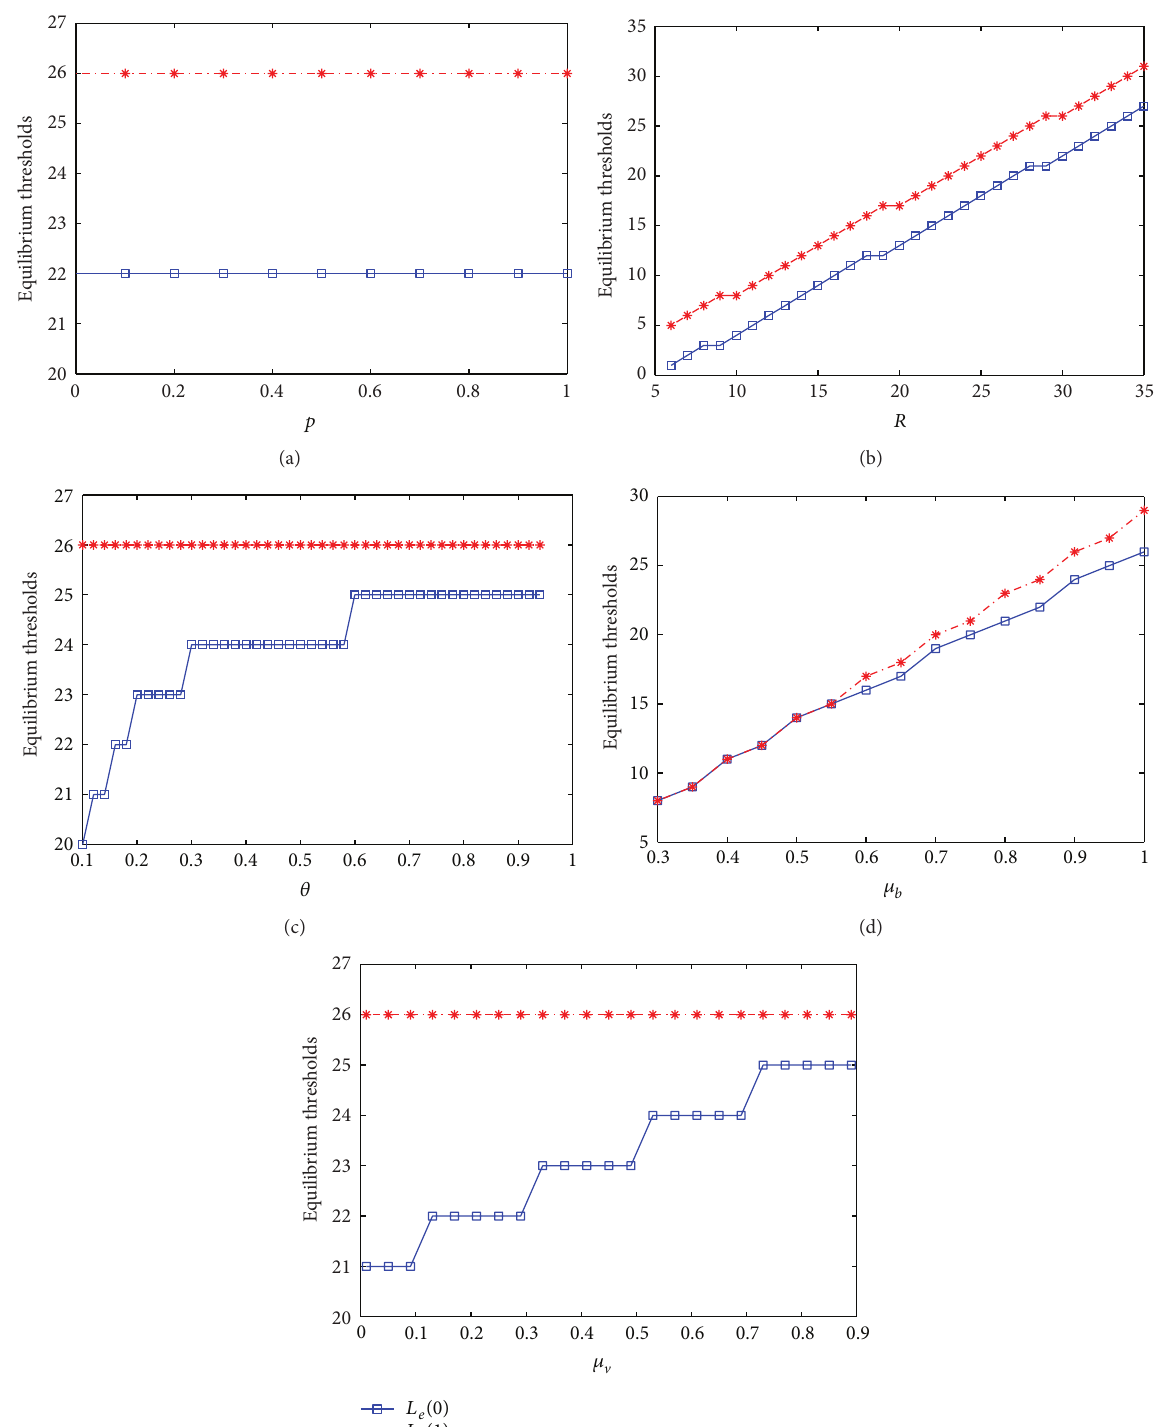
Figure 3: Equilibrium thresholds for the fully observable model. Sensitivity with respect to (a) 𝑝 , for 𝜇 𝑏 = 0.9 , 𝜇 V = 0.1 , 𝜃 = 0.2 , 𝐶 = 1 , 𝑅 = 30 ; (b) 𝑅 , for 𝑝 = 0.4 , 𝜇 = 0.5 , 𝐶 = 1 , 𝑅 = 30 ; (e) 𝜇 𝜇 V